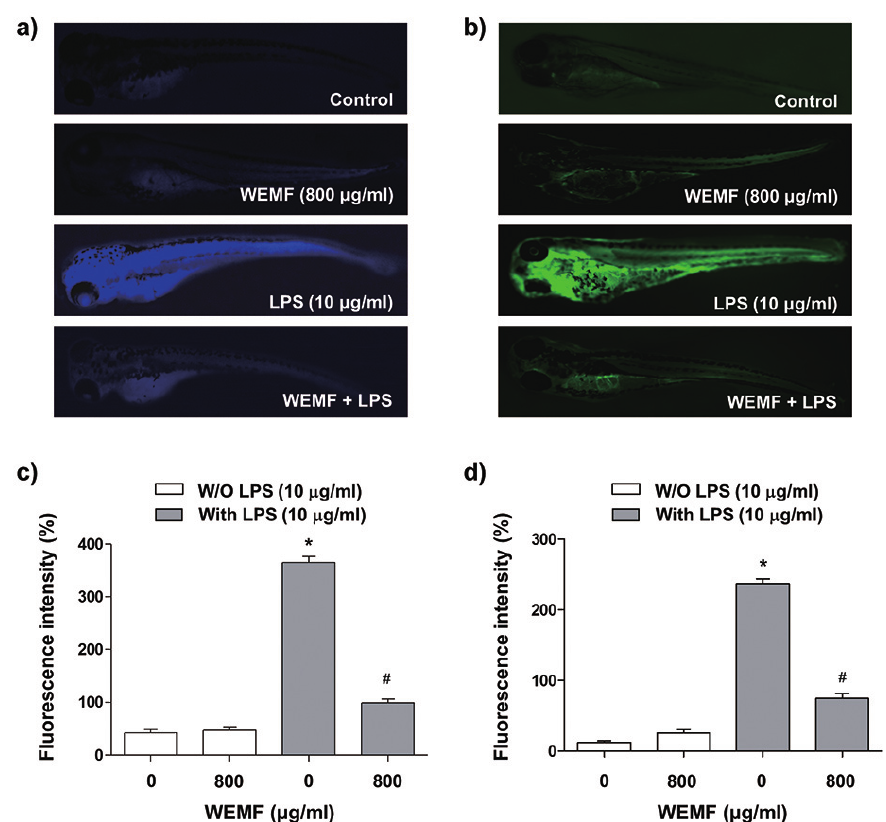
Figure 7 - Protective eff ect of WEMF on LPS-induced NO and ROS generation in zebrafi sh larvae. The zebrafi sh larvae were treated with 800 μg/ml WEMF and 10 μg/ml LPS for 24 h or pretreated with 800 μg/ml WEMF for 1 h prior to incubation with 10 μg/ml LPS for 24 h (a and b). The levels of NO and ROS generation were observed under a fl uorescence microscope after staining with DAF-FM-DA and DCF-DA, respectively (c and d). The fl uorescence intensities of NO and ROS levels in individual zebrafi sh larvae were quantifi ed. The values represented the means ± SD of three independent experiments ( # p<0.05 compared with the control; *p<0.05 compared with the LPS-treated